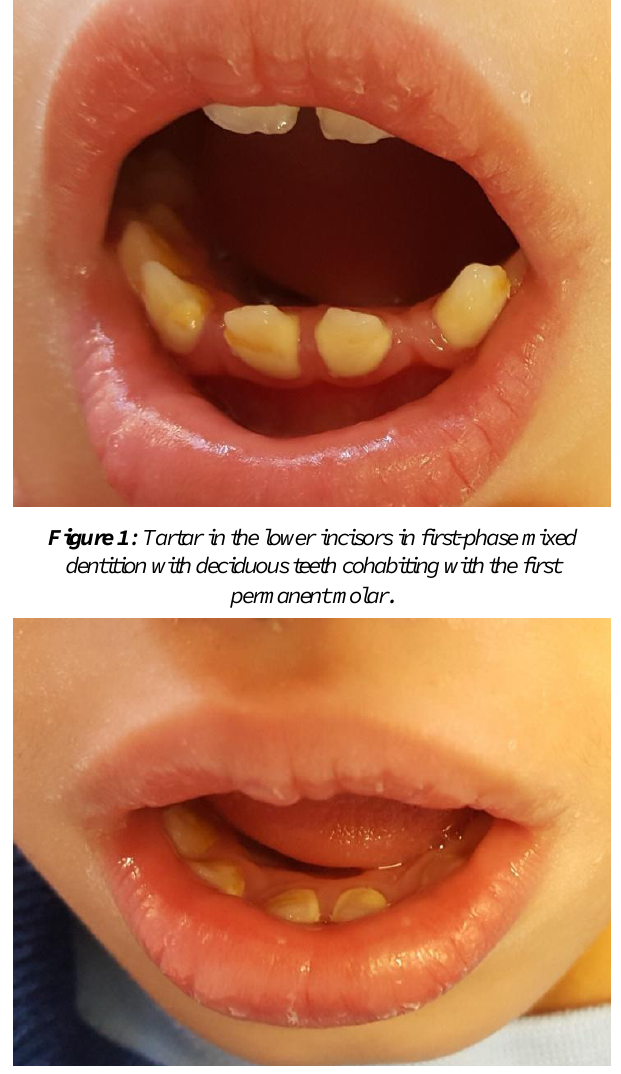
Figure 2 : Tartar in the lower incisors in the buccal/labial zone in first-phase mixed dentition with deciduous teeth cohabiting with the first permanent